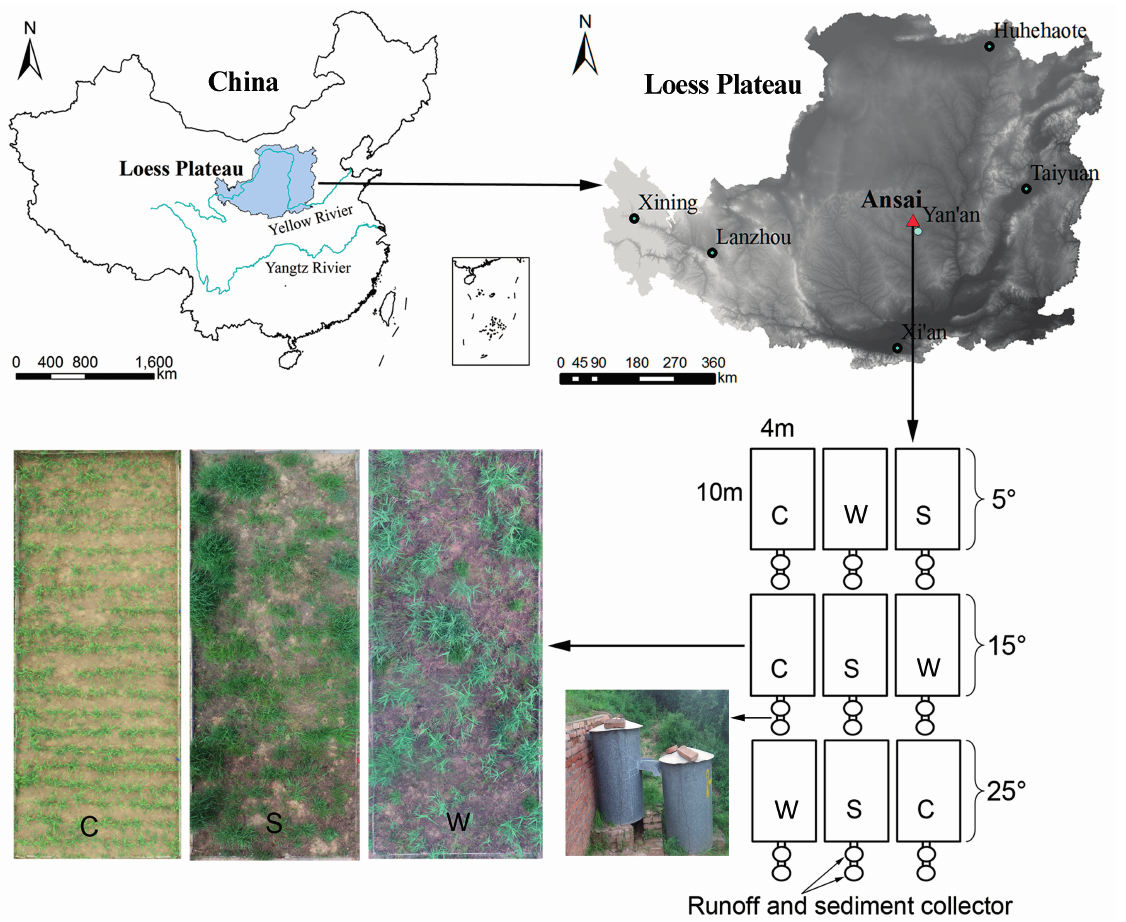
Figure 1. Location and layout of the runoff plot (C: cultivated land, S: switchgrass, W: wild